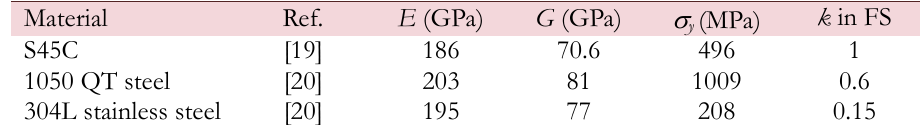
Table 1: Static properties of the investigated